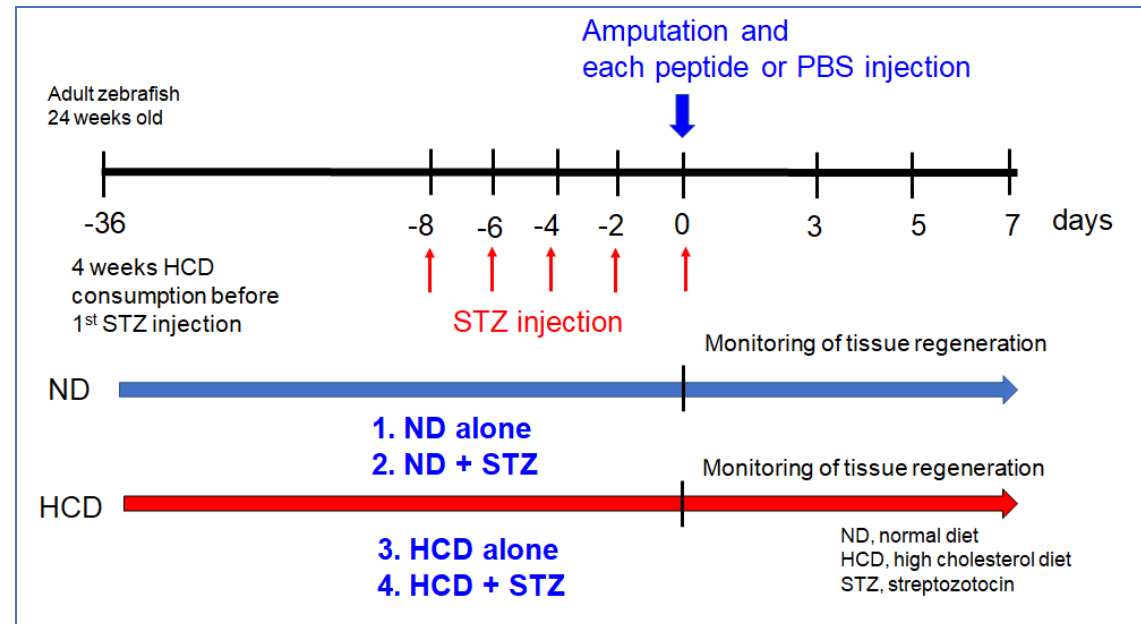
Figure 1. Experimental design of tail fin regeneration in the absence or presence of diabetic condition and hypercholesterolemia induced by 0.3% streptozotocin (STZ) injection and 4% cholesterol feeding. Four types of combination experiments were carried out to monitor the regeneration pattern of the tail fin over seven